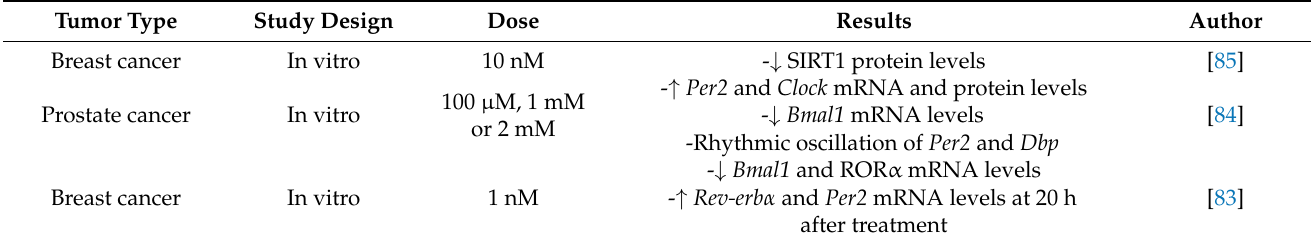
Table 1. The effect of exogenous melatonin on clock genes in different